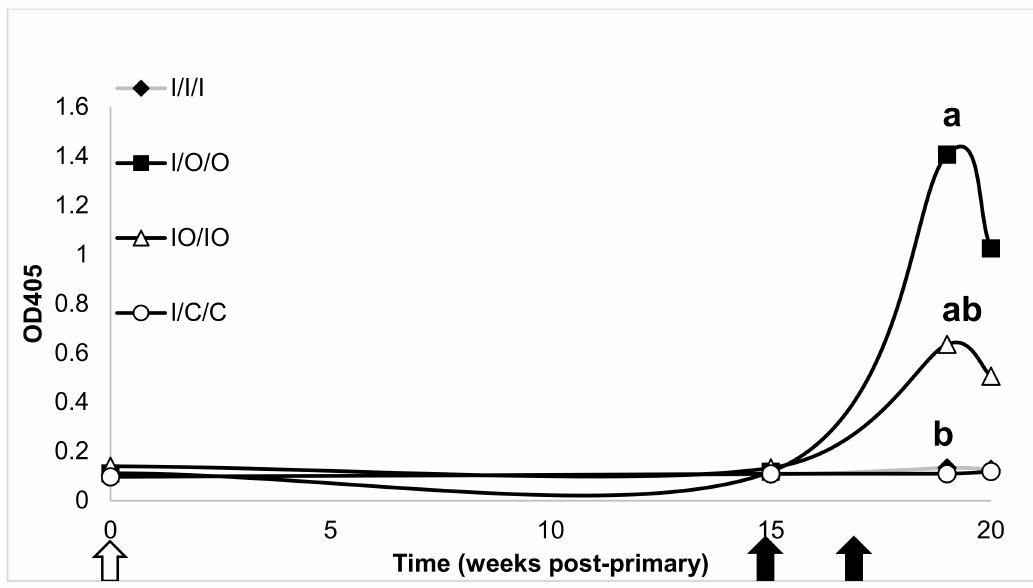
Figure 2. Vaginal IgA response to injected, oral, co-administered injected / oral or control treatments of HBsAg. Treatment groups as in Figure 1. The white arrow represents timing of the primary dose and the black arrows timing of boosting doses. Antibody levels were detected using an ELISA and statistical significance was assessed using ANOVA. Statistical analysis as in Figure